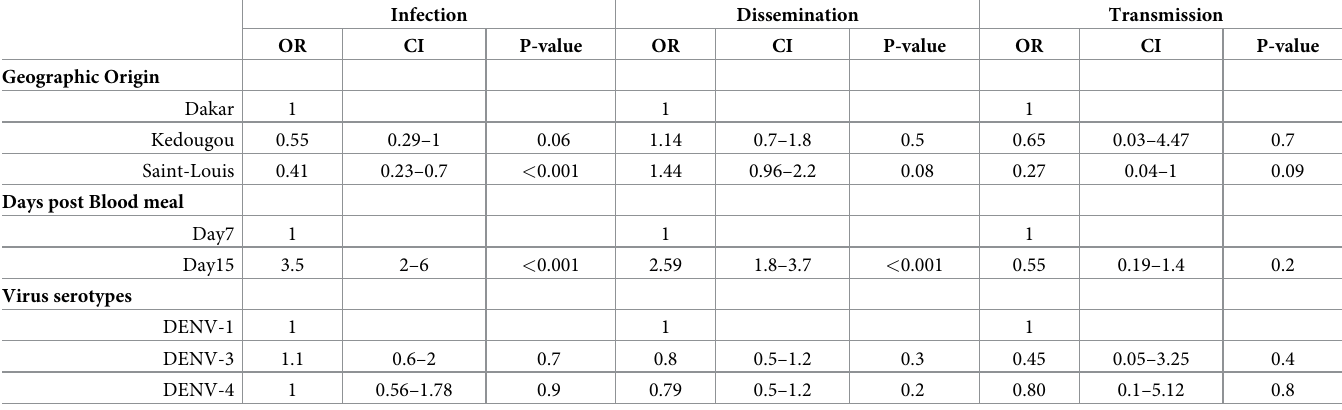
Table 5. Beta regression model estimating relationship between infection and virus serotype, incubation and mosquito